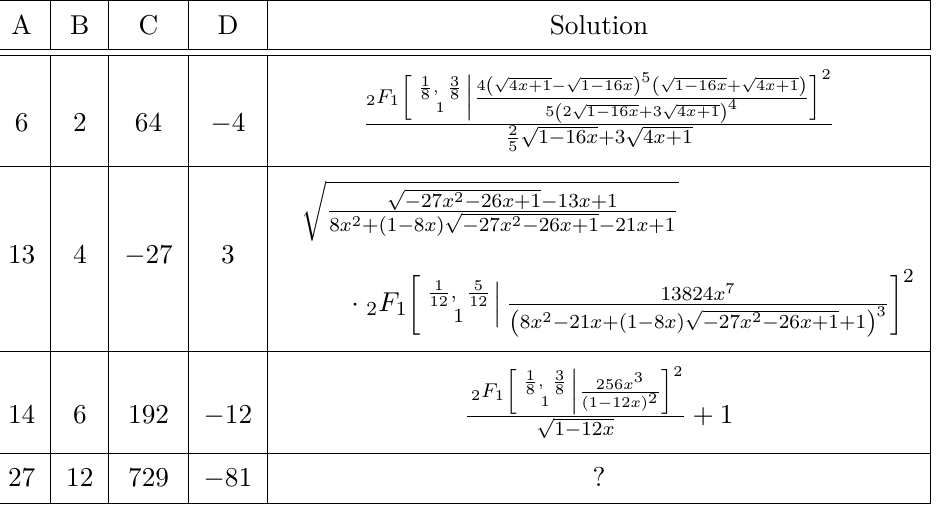
Table 2 . Solutions to Apéry-like recursions (3.5) found by Cooper [66]. The appearing hypergeo- metric functions can be transformed into the Γ (2) − case in [23]. This is the only case where a closed form is 0